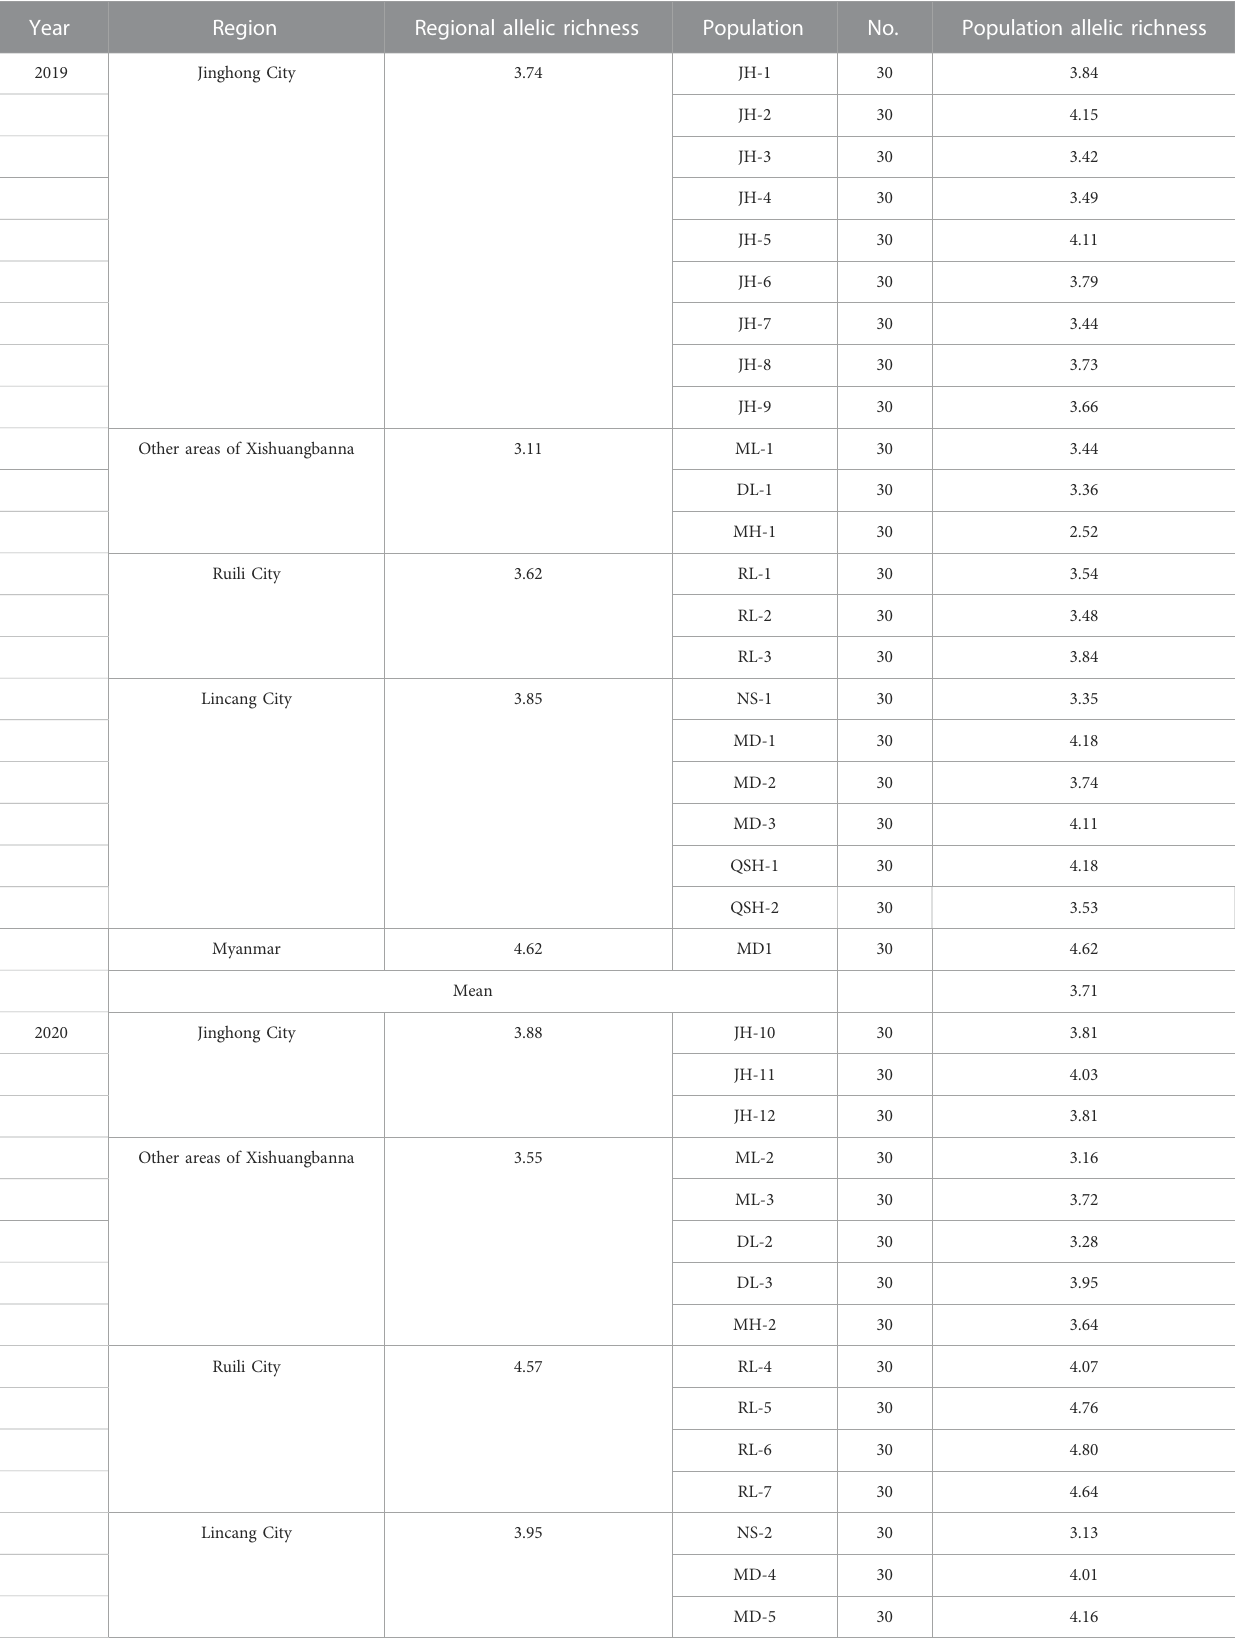
TABLE 4 Allelic richness of all populations in 2019 and